Question: Condense the content of this figure into a single sentence.
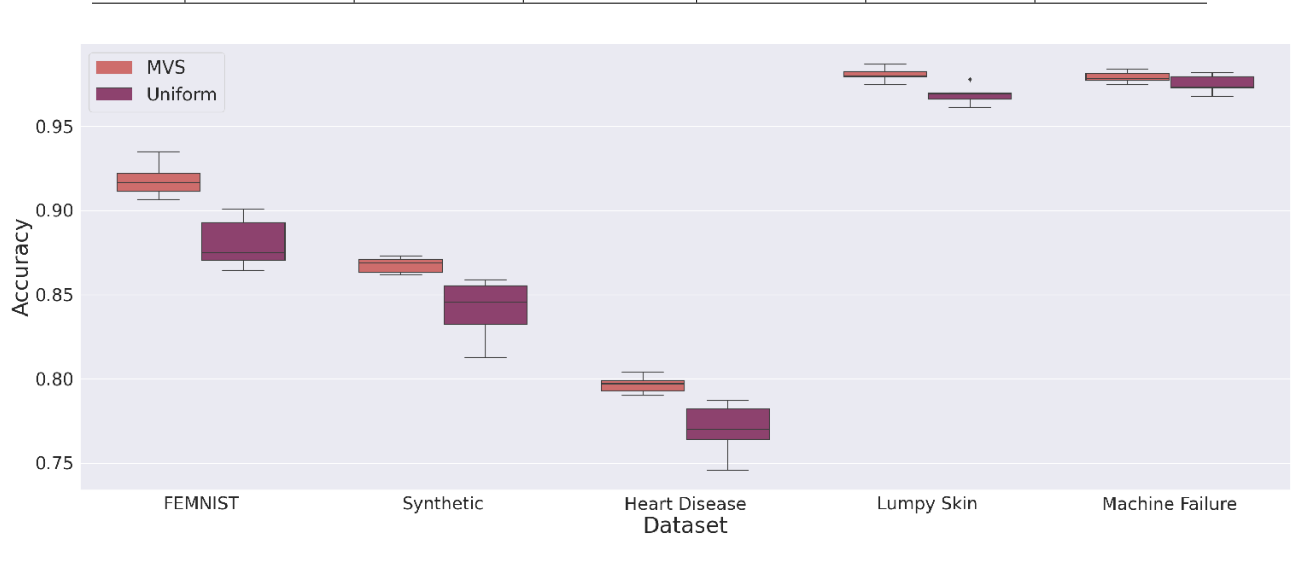
Answer: Top 1% evaluation accuracy for different F-XGB sampling methods. 50% sampling fraction is used for F-XGB on all datasets and mean scores across 5 runs